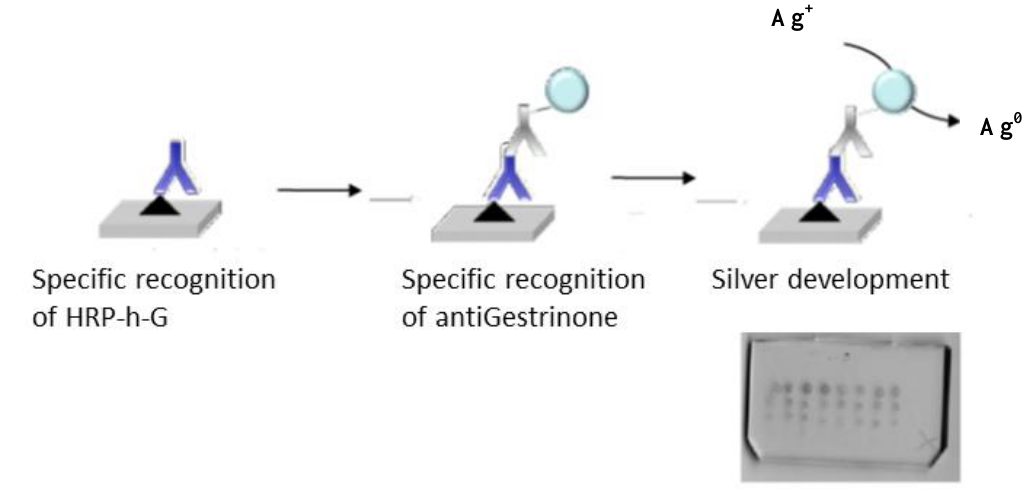
Figure 4. Scheme of the bioassay designed to test the bioavailability of the hapten-protein conjugate molecules attached to the SU-8 surface and scanned image obtained for the